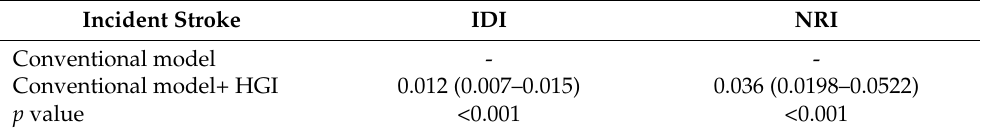
Table 4. Reclassification analysis of HGI in improving conventional stroke model. Incident Stroke